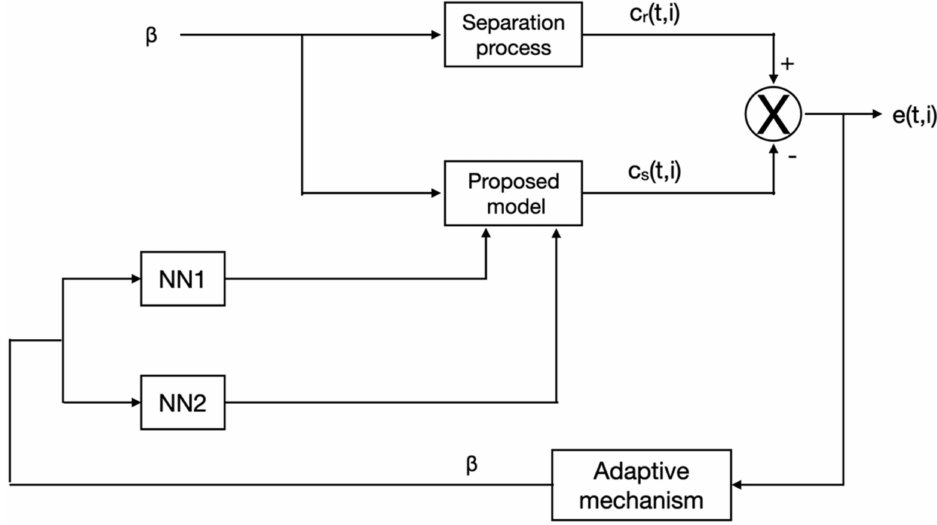
Figure 11. The proposed adaptive structure for the isotopic separation process